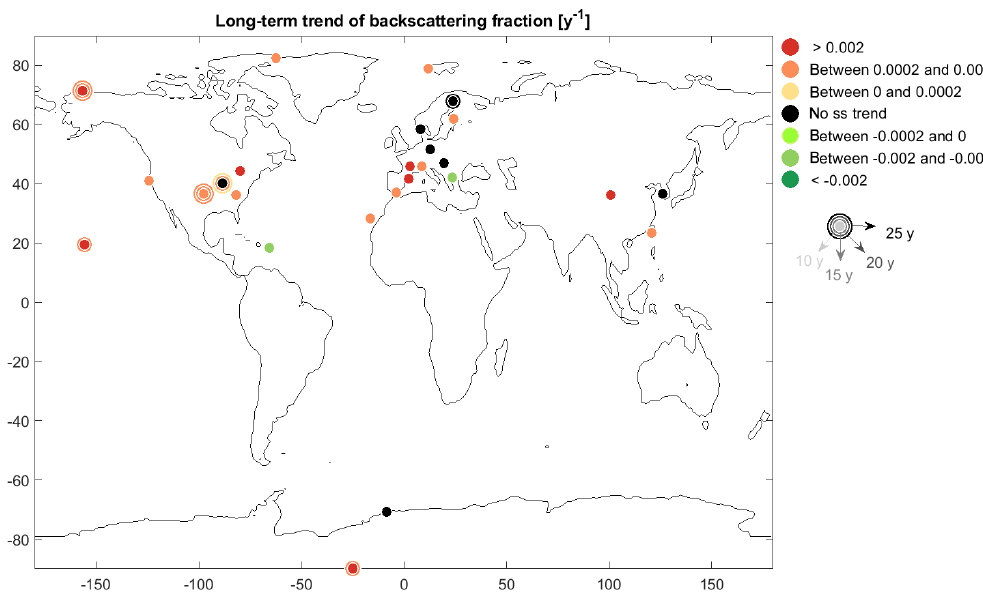
Figure 9. MK trend results for the backscattering fraction. Other details same as Fig. 4.